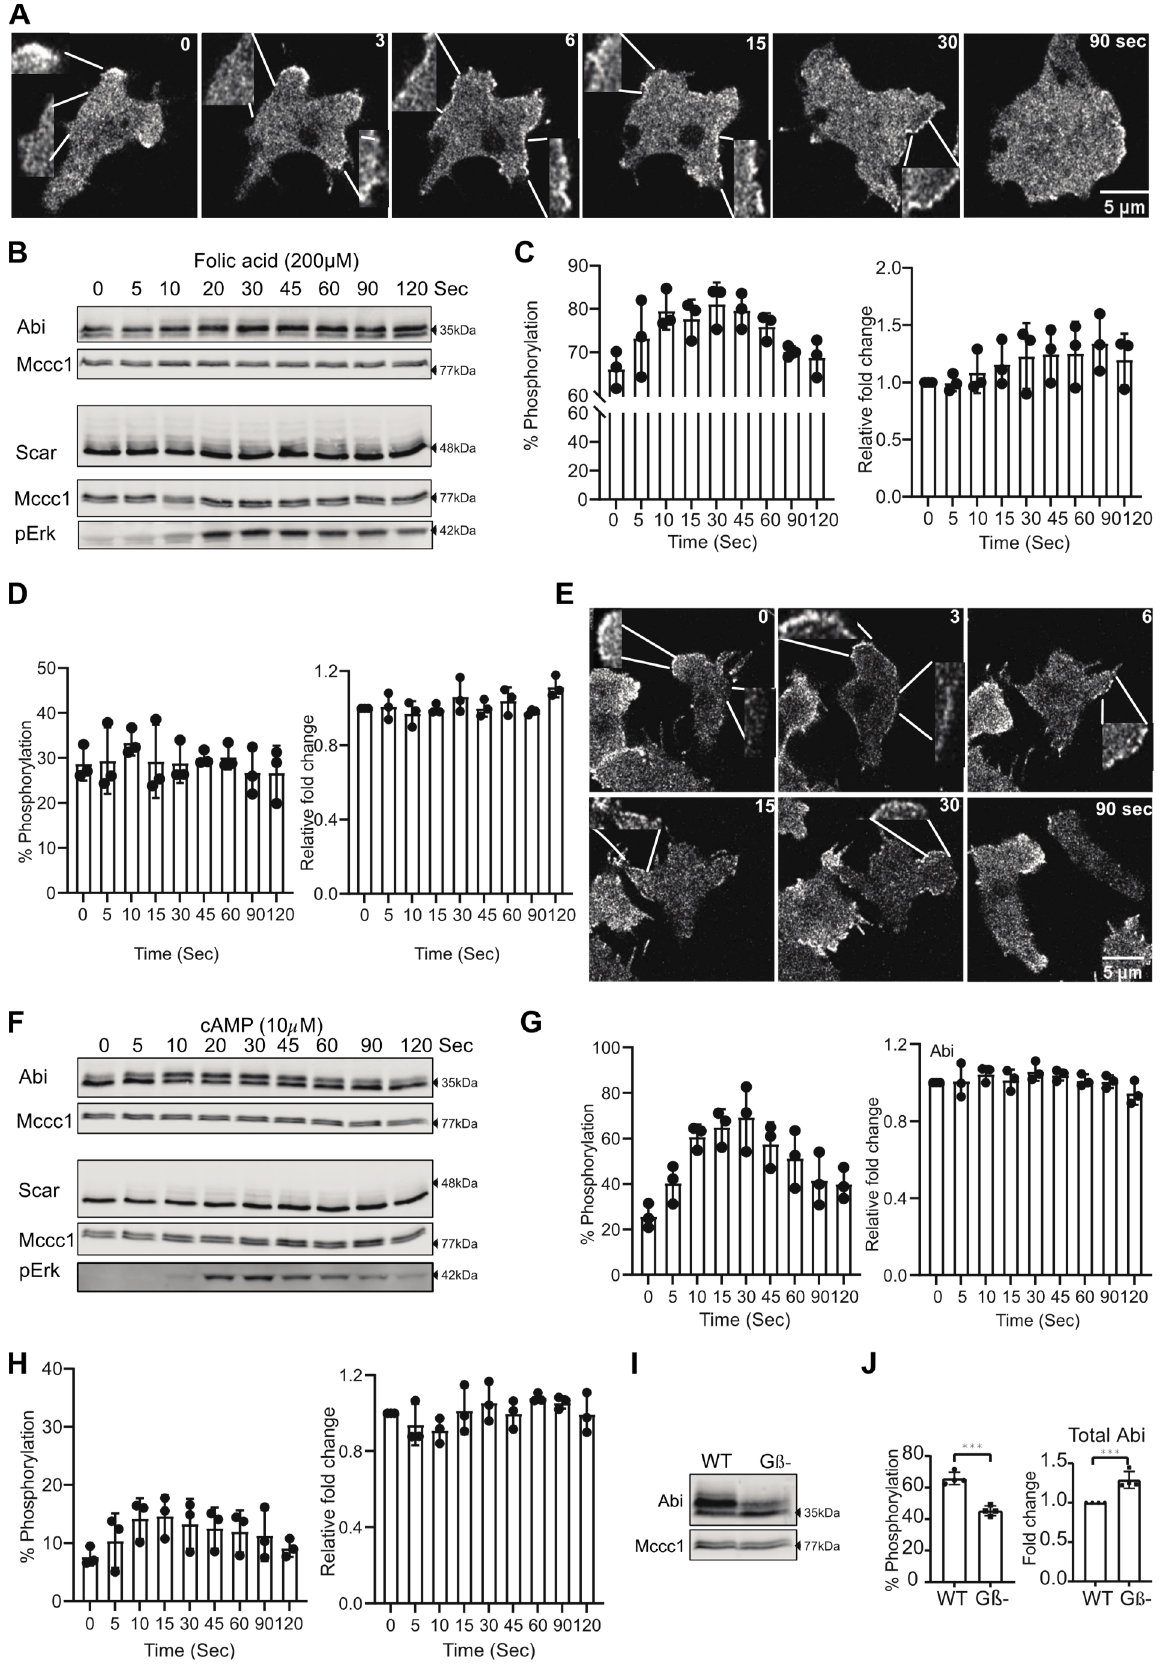
Figure 2. Signaling dependent phosphorylation of Abi and Scar. ( A ) Redistribution of the Scar/WAVE complex after